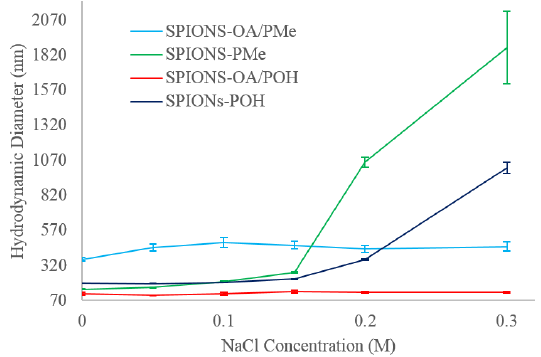
Figure 2. Hydrodynamic diameters measured from dynamic light scattering (DLS) at various Sodium chloride (NaCl) concentrations for all water-dispersible Super paramagnetic iron oxide nanoparticles (SPIONs).